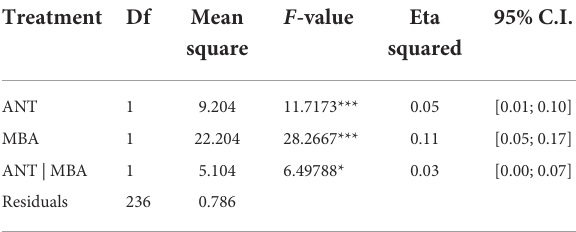
TABLE 11 Factorial ANOVA analysis of effects of BA and ANT on users’ overall perception.